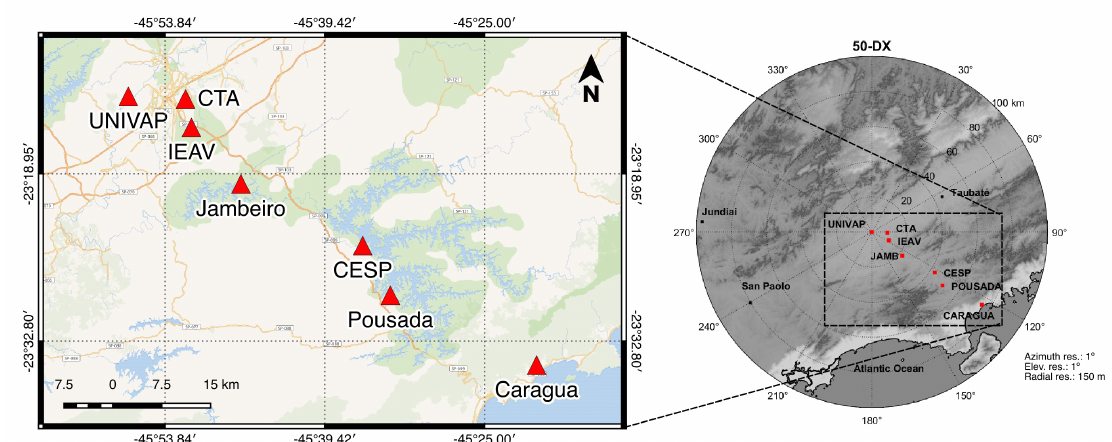
Figure 1. Position of the X-band radar and of the rain gauges indicated with a thumbtack in each site, during the Vale do Paraíba